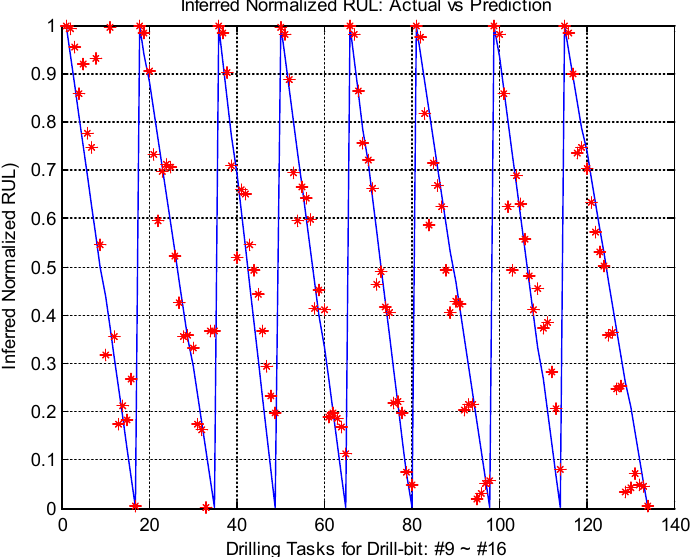
Figure 7. Normalized inferred RUL (blue line) vs. predicted RUL (red dotted line) for drill-bits #9~#16.